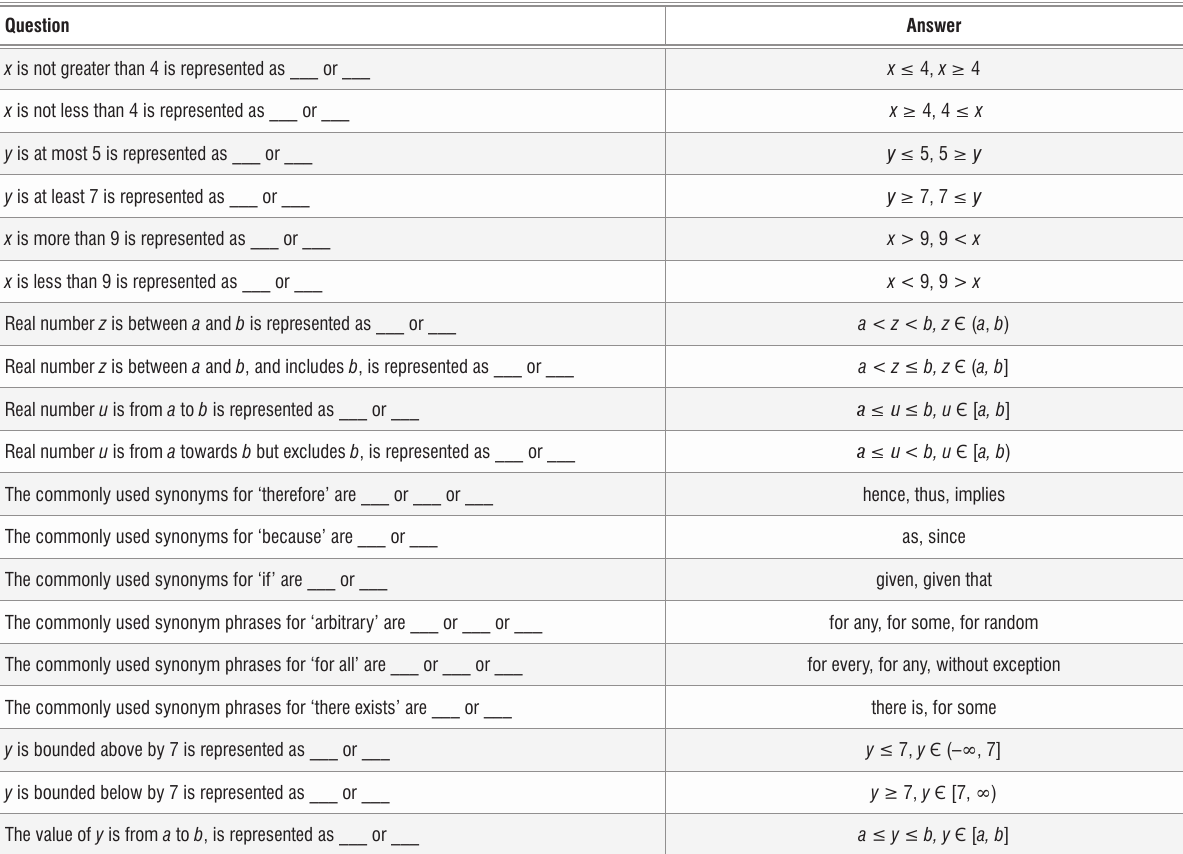
Table 4: Sample questions and answers for mathematical